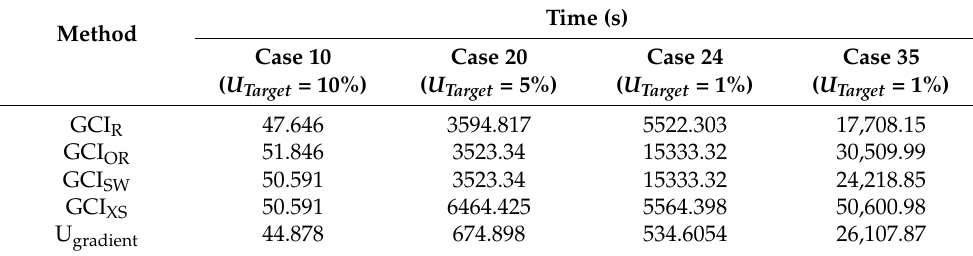
Table 5. Several Examples of Required Simulation